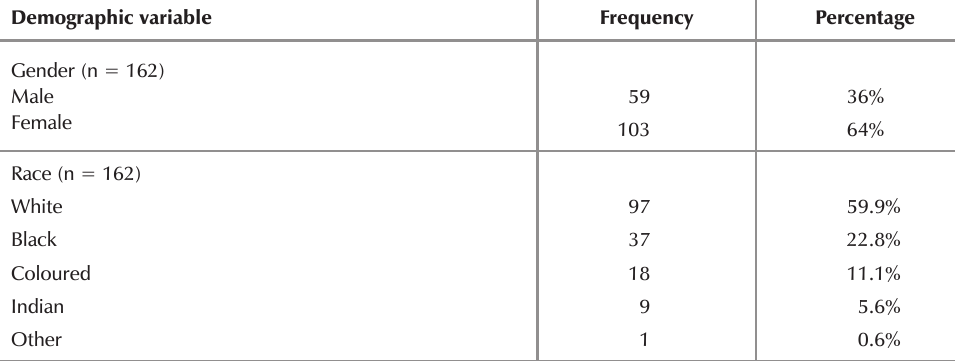
Frequency distribution of demographic variables of the